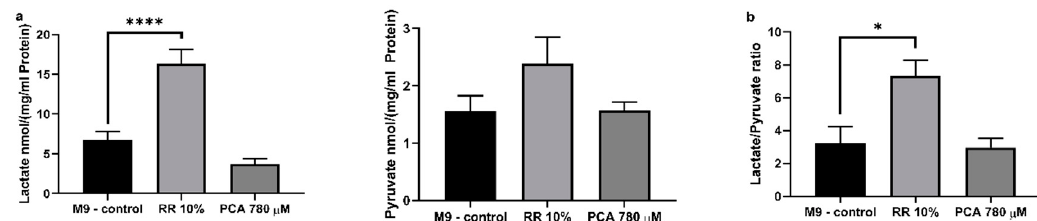
Figure 7. (a) Assessment of intracellular lactate and pyruvate concentrations in nematode homogenate and ( b ) the consequential lactate/pyruvate ratio. Levels were determined using two colorimetric lactate and pyruvate assay kits from Sigma (Sigma Aldrich, St. Louis, MO, USA). Values were normalized to protein concentrations; n = 8; mean ± SEM; one-way ANOVA with Tukey’s multiple comparison posttest; p * < 0.05 and p **** < 0.0001.